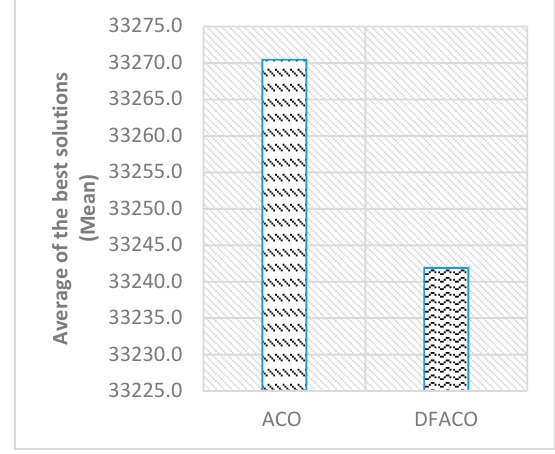
Figure 6. DFACO and ACO comparison in terms of Mean as shown in Table 2 .